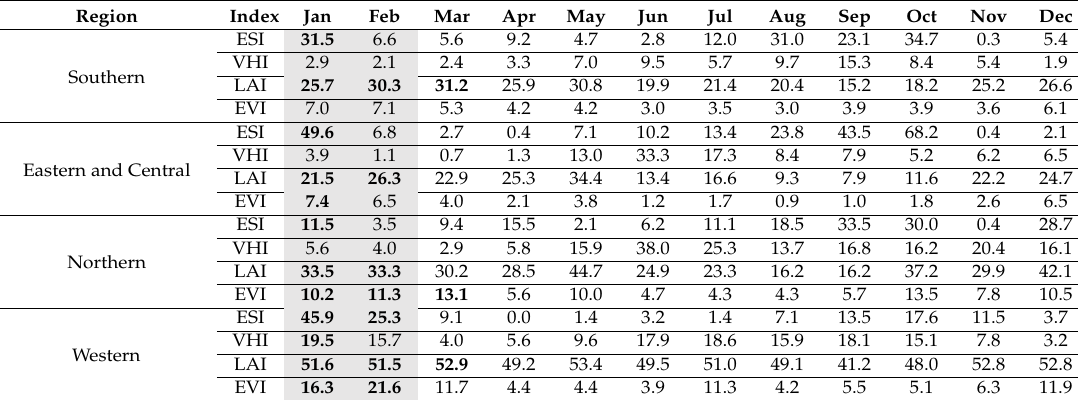
Table 4. Comparison of drought rate by region and actual drought periods, Taiwan, 2017 (%). Region ESI Eastern and Central